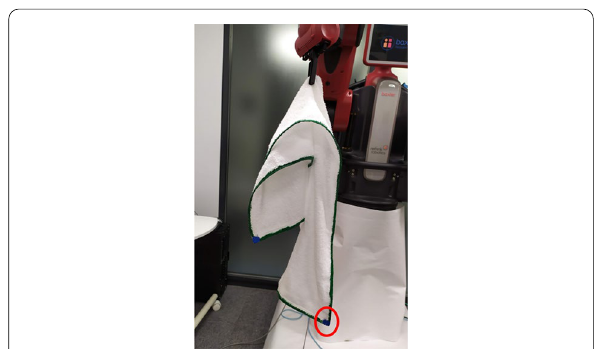
Fig. 3 When grasping the garment from a random point, the lowest point from a frontal view corresponds to one of its